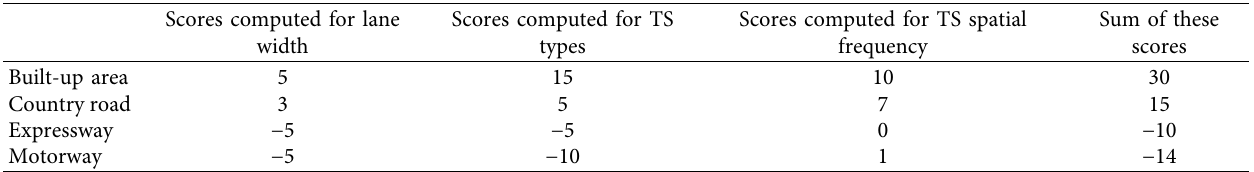
Table 4: The local scores computed for lane width, TS types, and the spatial frequency of the TSs—measured/taken at a particular road